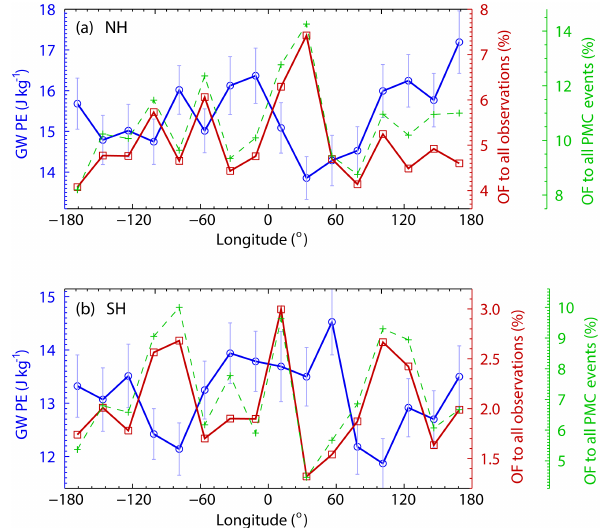
Figure 11. Longitudinal distributions for the occurrence frequen- cies (OF) of double-layer PMCs to all observations (red) and all PMC events (green) shown in Fig. 10. While the longitudinal dis- tributions of mean GW PEs (blue) are calculated by averaging the data of all PMC seasons during 2007–2014. Error bars show the standard deviation of the